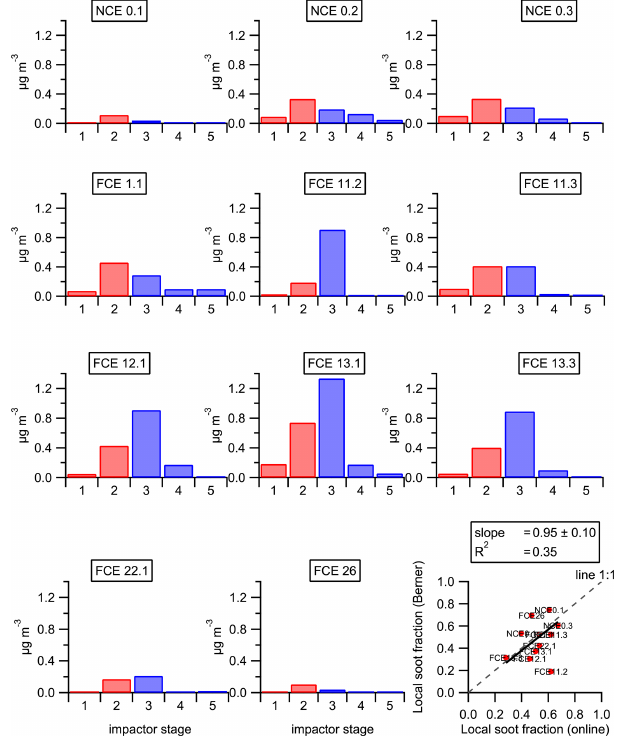
Figure 8. Overview of the EC size distribution measured by the five-stage Berner impactor. Colors correspond to the following EC classifications: red is local, and blue is regional/transport. The scat- ter plot on the bottom right shows the comparison between the local soot fractions estimated using the two different approaches, namely the Berner impactor ( y axis) and online multilinear regression ( x axis). Regression (black line) was made using the least orthogonal distance fit method.